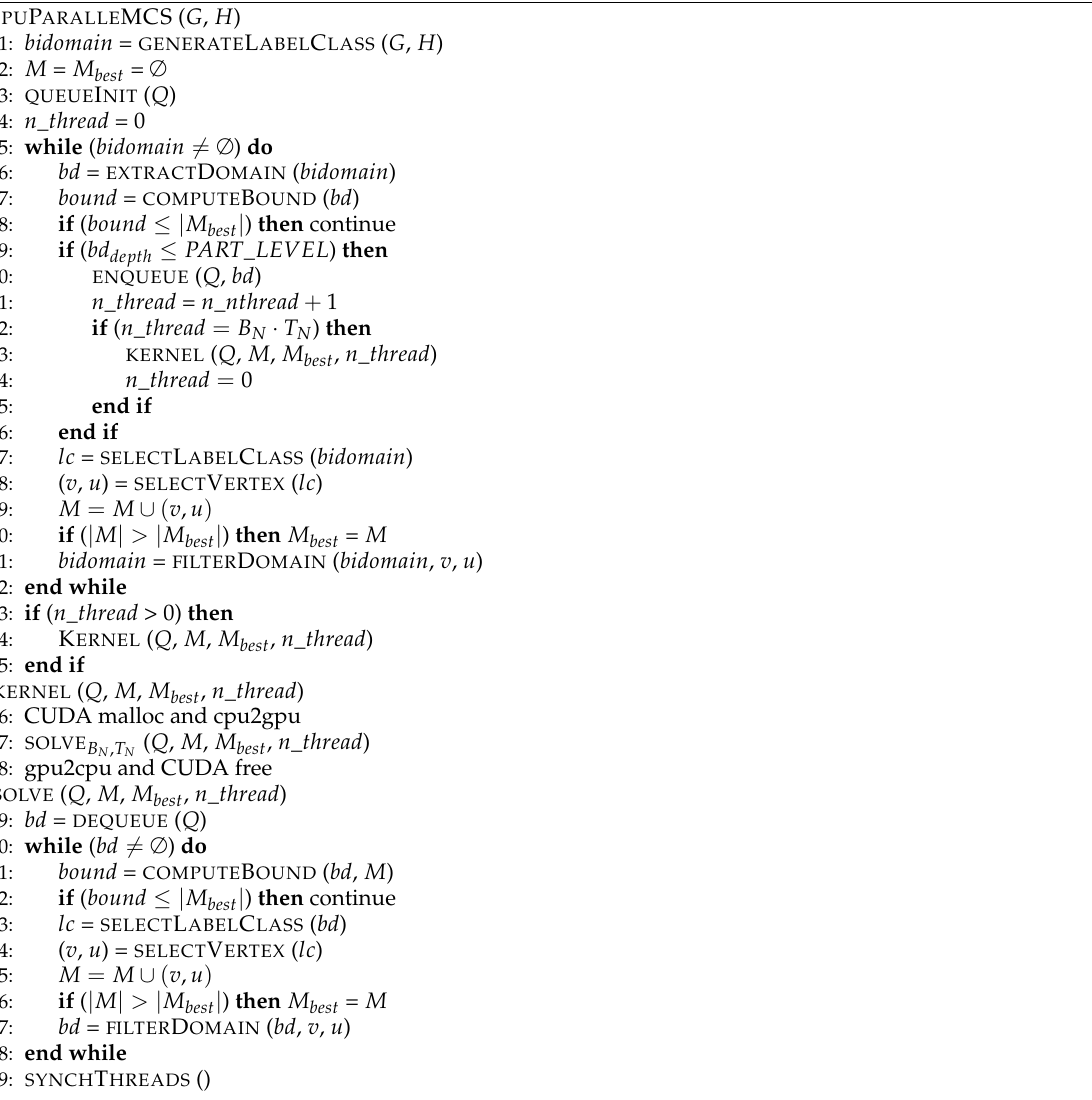
Algorithm 2 The many-core GPU-based iterative branch-and-bound MCS procedure. GPU P ARALLE MCS ( G , H